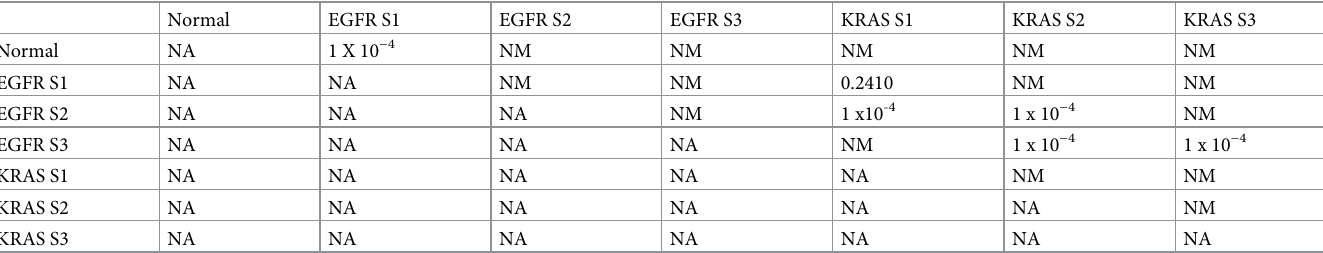
Table 2. P-value results of pairwise Mann-Whitney testing select conditions for nuclear volume of near-euploids. Normal Normal